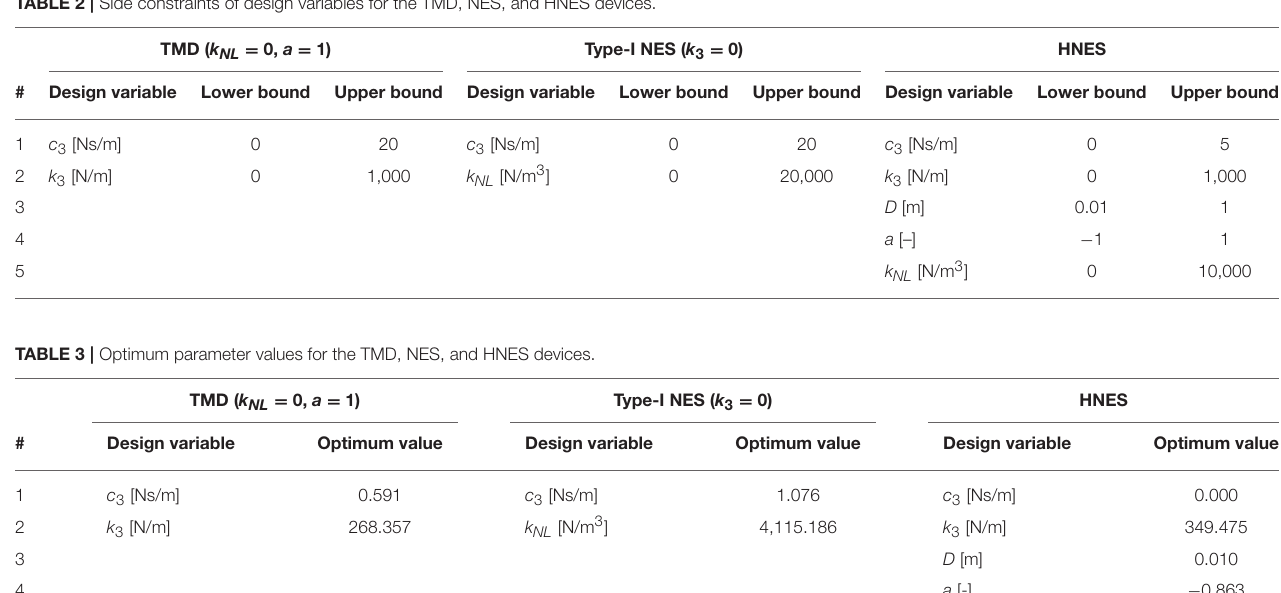
TABLE 2 | Side constraints of design variables for the TMD, NES, and HNES devices.